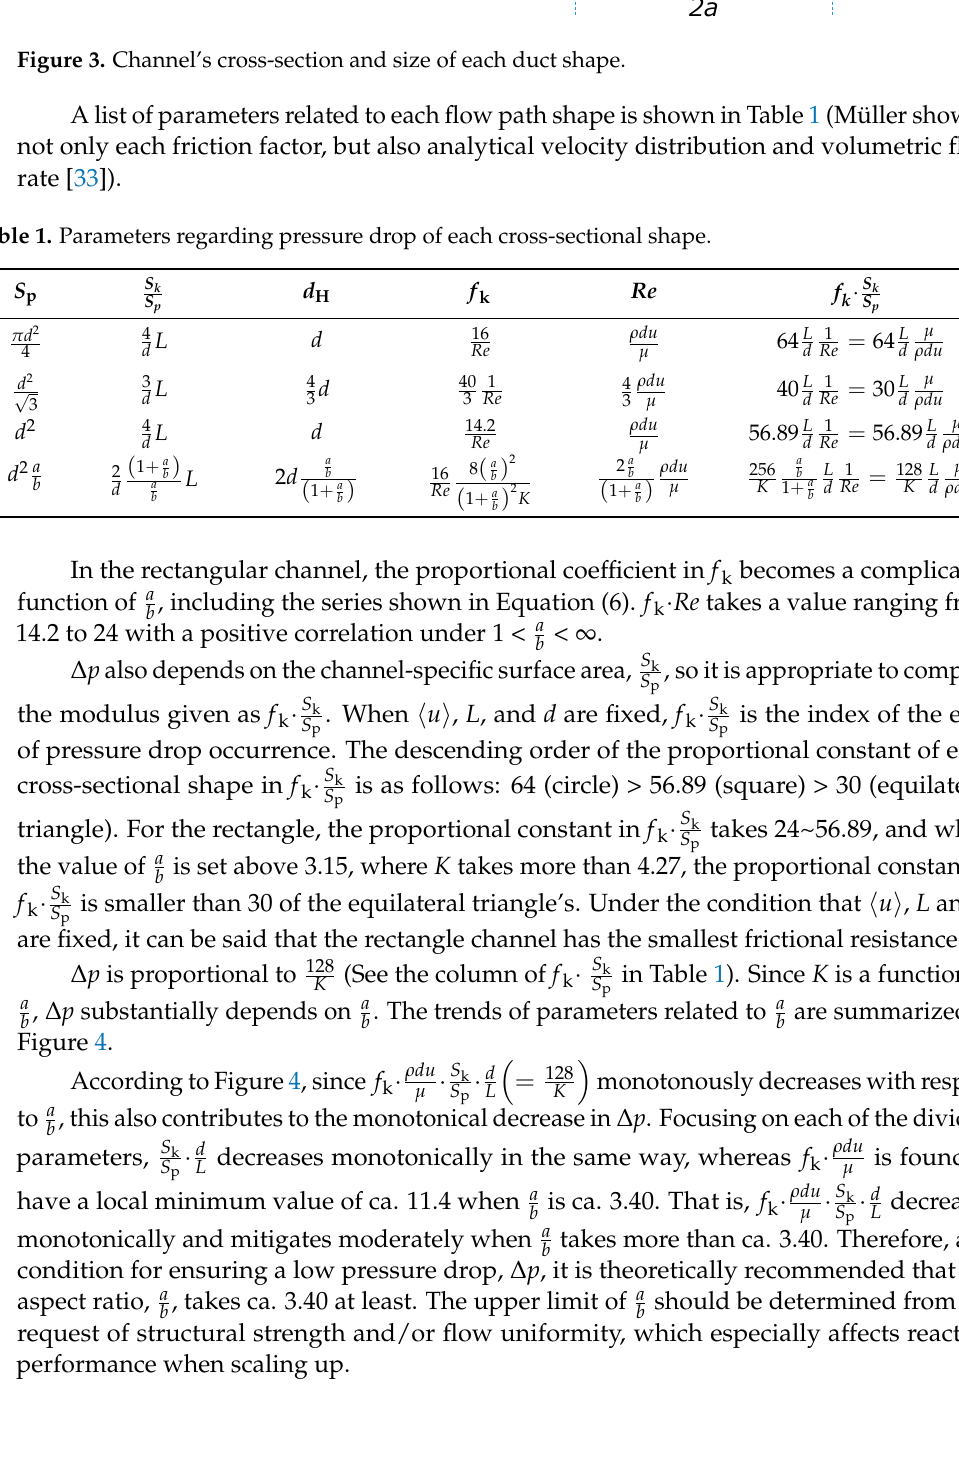
According to Figure 4, since 𝑓 (cid:2921) ∙ 𝜌𝑑